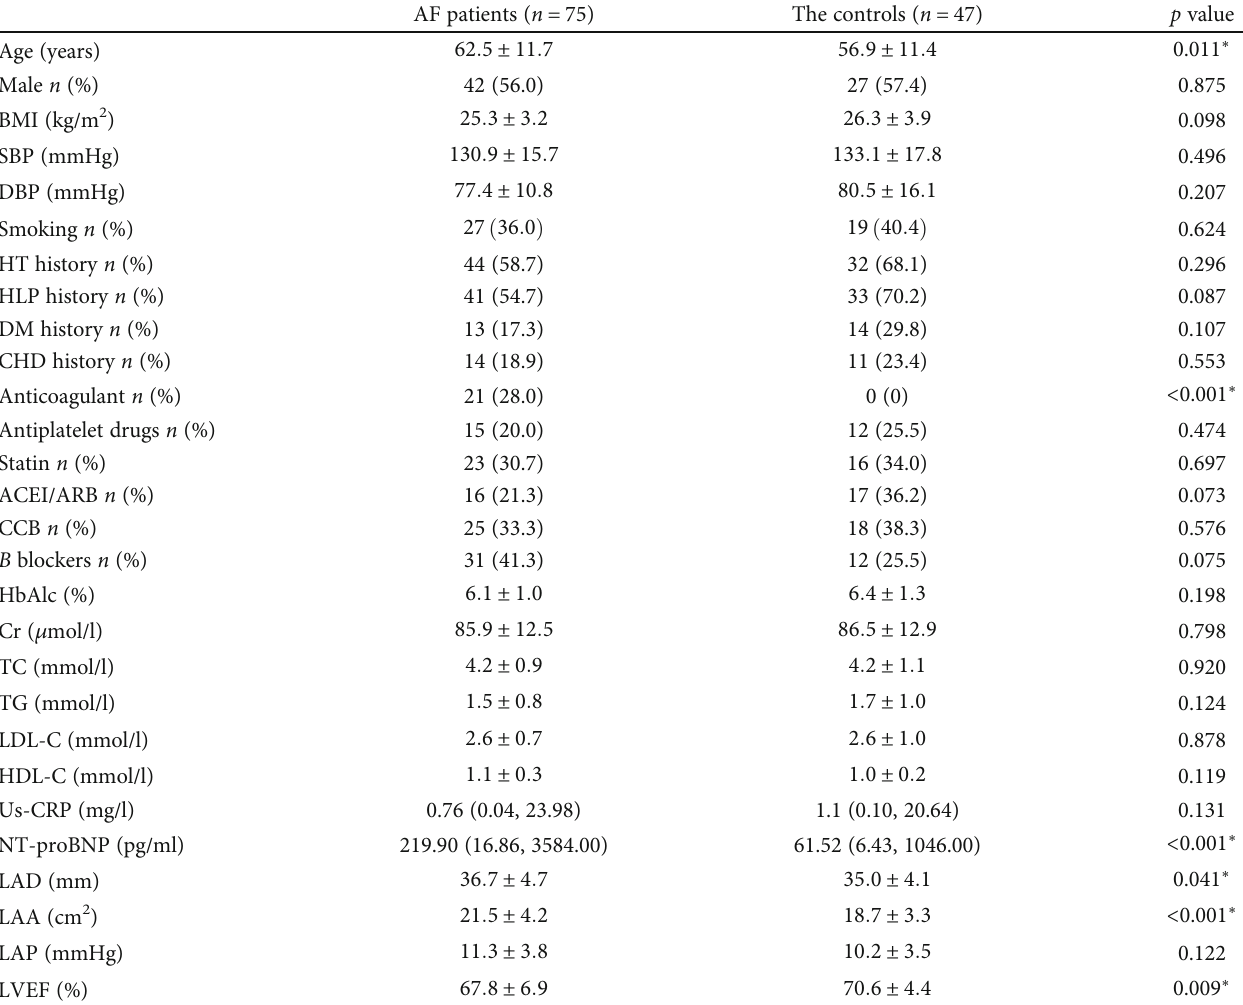
Table 1: Clinical and biochemical characteristics of AF patients and